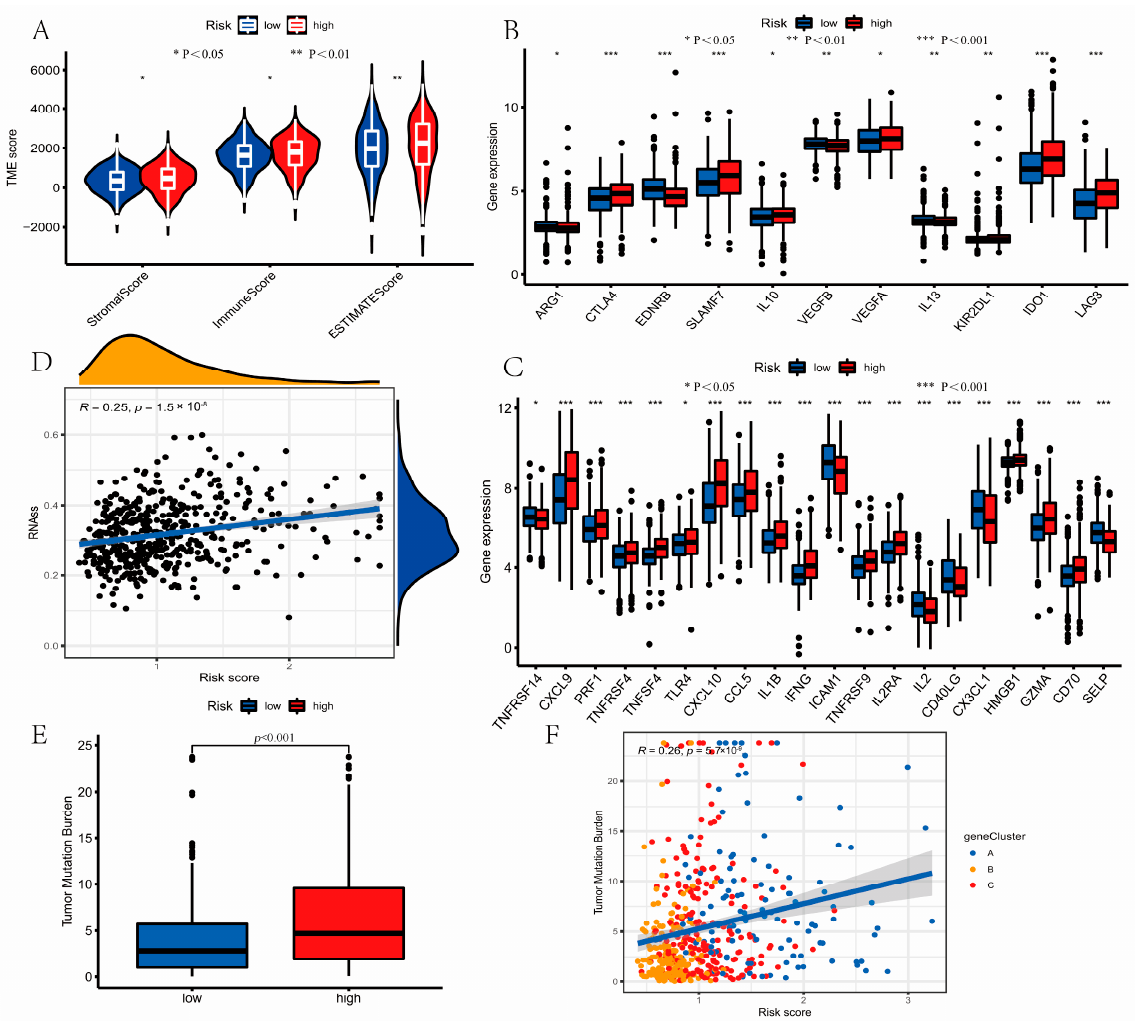
Figure 8. Evaluation of tumor microenvironment (TME) and tumor mutation burden (TMB) between the high- and low-risk groups. ( A ) The differences in stromal score and immune score between risk groups. A high-risk score was closely related to a high stromal score and immune score. ( B , C ) The expression of 11 inhibitory immune checkpoints and 20 stimulatory immune checkpoints was significantly different between the distinct risk groups, using the Wilcoxon test. ( D ) The correlations between the CSC index and risk score using Spearman’s correlation analysis. ( E , F ) The correlations between TMB and risk score using Spearman’s correlation analysis. Compared with the high-risk group, the low-risk group had lower TMB. * P < 0.05, ** P < 0.01, *** P < 0.001.